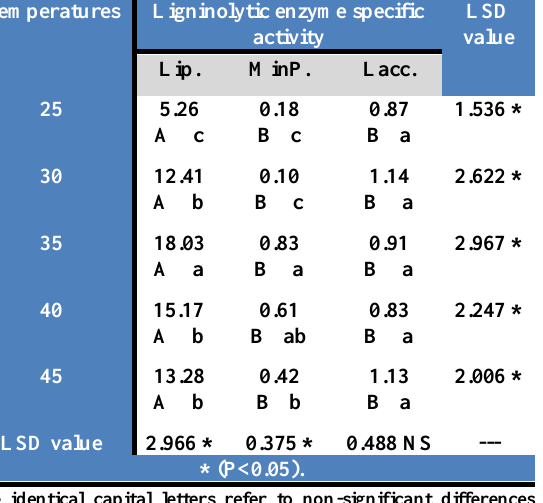
Effect of Temperatures and enzymes production in specific activity